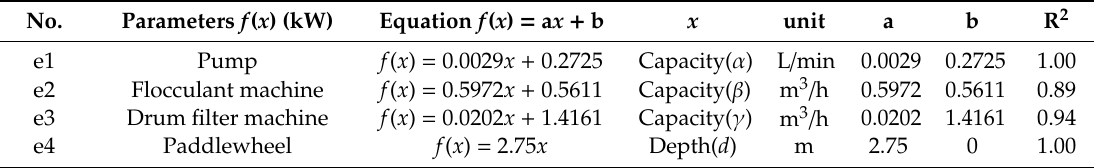
Table 5. Function list of “electricity” for dependent parameters (derived from Reference